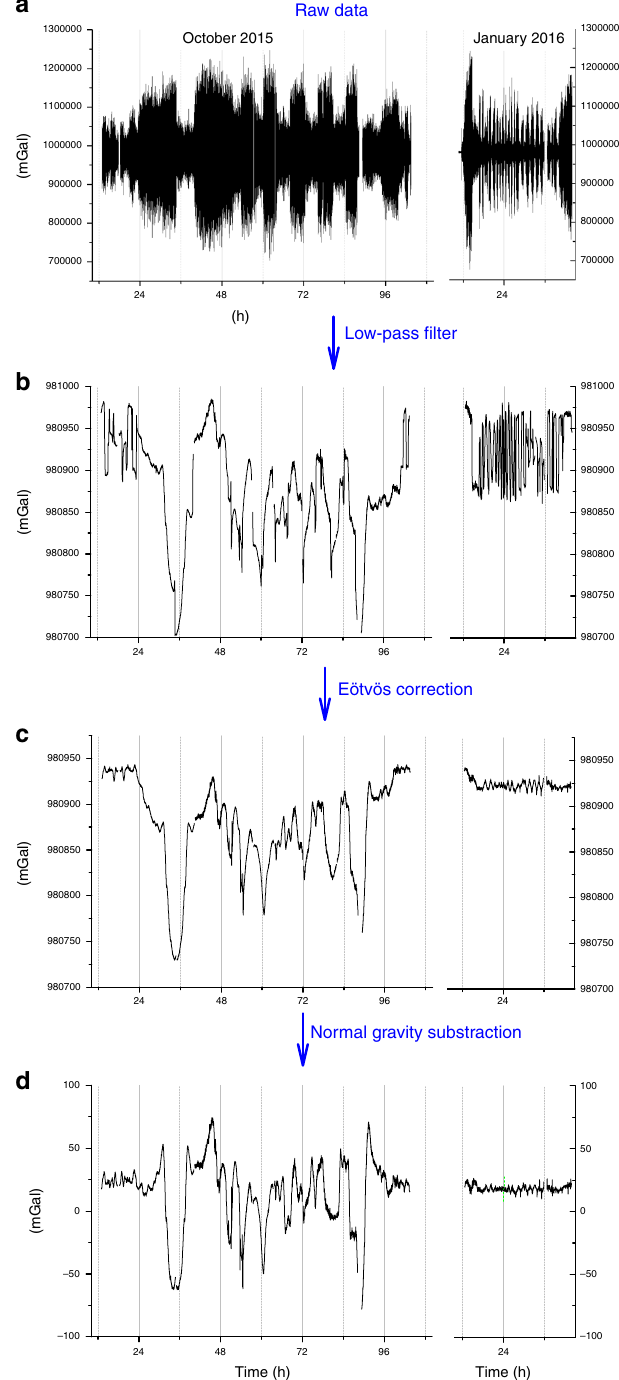
Fig. 7 Illustration of data processing during the gravimetric survey of October 2015 and January 2016. a Raw data ( g + a ship + a Eötvös ). b Raw data low-pass fi ltered with a Bessel 4th order fi lter of time constant 130 s ( g + a c Gravity measurements ( g ). d Gravity anomaly measurements ( g − g norm